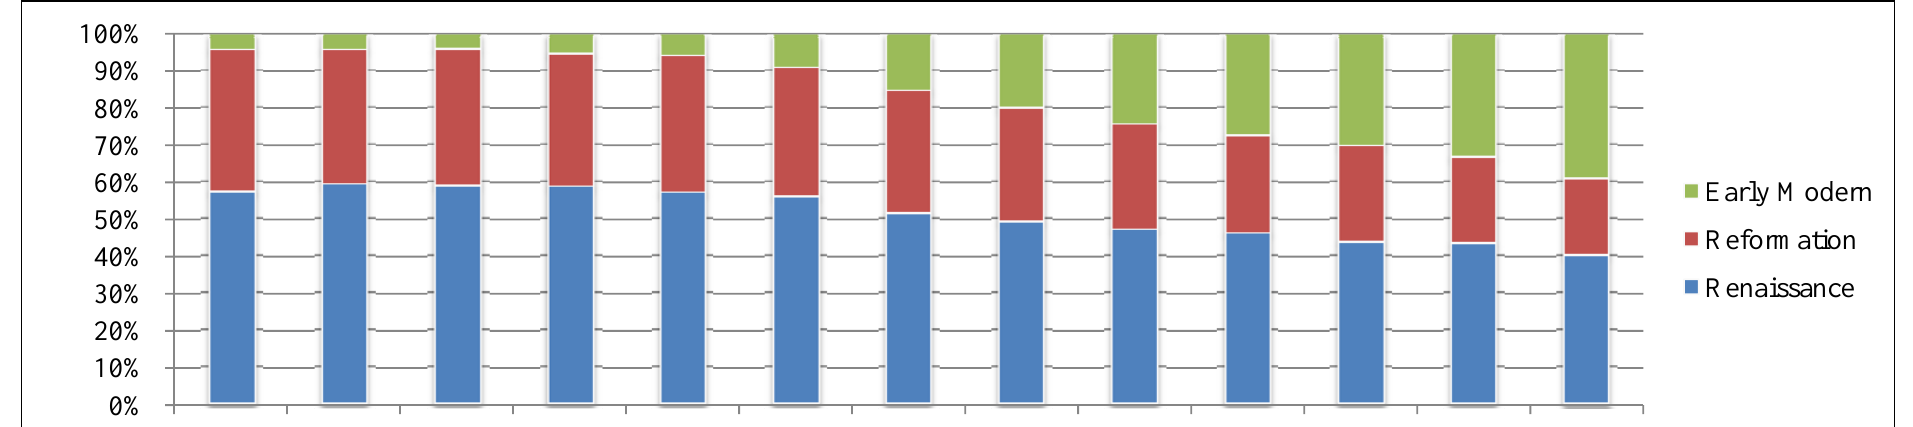
Chart 1. Relative Frequency of Renaissance, Reformation, and Early Modern in History Journals on